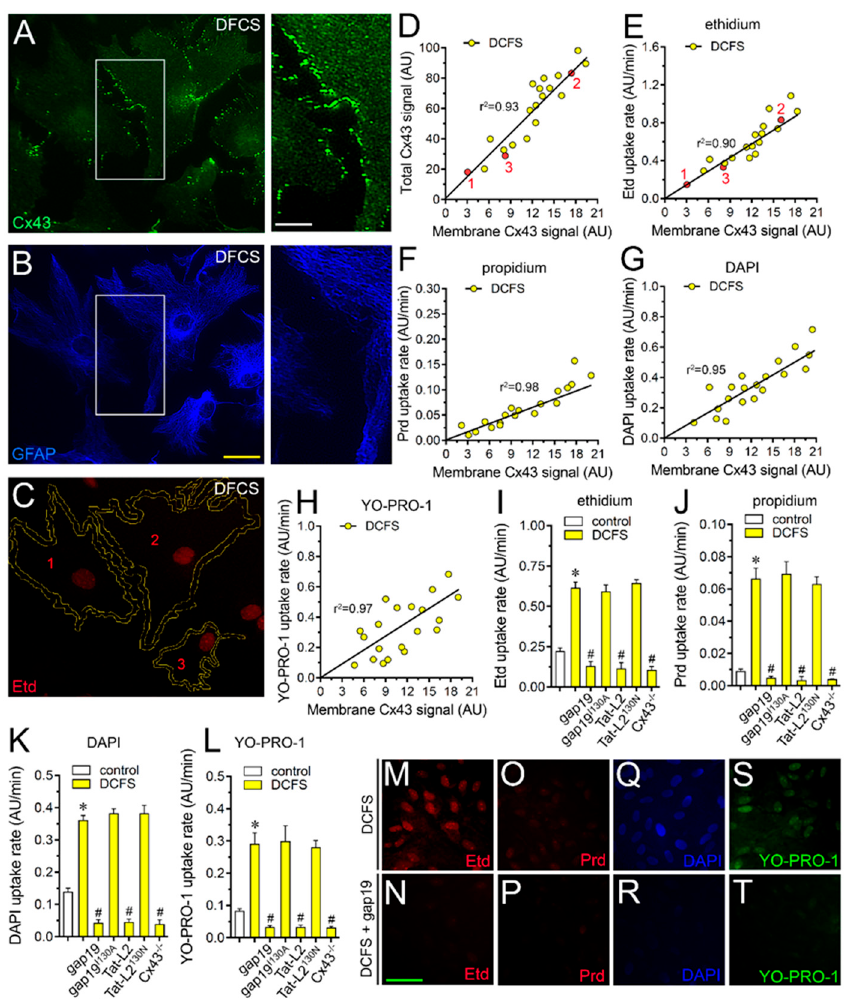
Figure 2. Uptake of nucleic acid dyes depends on Cx43 hemichannels in cultured astrocytes exposed to a divalent cation-free solution. ( A – C ) Representative confocal images depicting Cx43 (green, A ), GFAP (blue, B ) and Etd (red, C ) staining by astrocytes bathed with DCFS for 10 min in the presence of 5 µM Etd. Right insets: 1.8× magnification of the indicated area of panels A and B. ( D ) Representative linear regression analysis showing the relationship between the total and cell periphery (cell surrounding) immunostaining signal of Cx43 in cultured astrocytes bathed with DCFS (yellow circles). Note that red points in the graph correspond to the Cx43 fluorescence values between inner and outer yellow lines shown for cells 1–3 in panel C. Pearson ′ s r was 0.94 ( p < 0.0001). ( E – H ) Representative plots of linear regression analysis showing the relationship between uptake rate of Etd ( E ), Prd ( F ), DAPI ( G ) or YO-PRO-1 ( H ) and intensity of membrane immunostaining signal for Cx43 in astrocytes bathed with DCFS (yellow circles). The values for Pearson’s r were statistically significant ( p < 0.0001) for all dyes studied: Etd (0.95), Prd (0.96), DAPI (0.96) or YO-PRO-1 (0.96). ( I – L ) Averaged uptake rate of Etd ( I ), Prd ( J ), DAPI ( K ) or YO-PRO-1 ( L ) of astrocytes bathed with control saline (white bars) or DCFS (yellow bars). Cells were exposed for 5 min to 5 µM of each dye. It is also shown the response of astrocytes knock-out for Cx43 or the impact of the following pharmacological agents: 100 µM gap19, 100 µM gap19 I130A , 100 µM Tat-L2 or 100 µM Tat-L2 H126K/I130N . * p < 0.05, DCFS vs. control; # p < 0.05, pharmacological agents vs. DFCS (two-way ANOVA followed by Tukey’s post hoc test). ( M – S ) Representative fluorescence images depicting Etd ( M , N ), Prd ( O , P ), DAPI ( Q , R ), and YO-PRO-1 ( S , T ) staining from dye uptake measurements (10 min exposure to each dye) in astrocytes exposed to DCFS alone (upper panels) or plus 100 µM gap19 (below panels). Calibration bars: white 6 µm; yellow: 20 µm; and green: 40 µm.